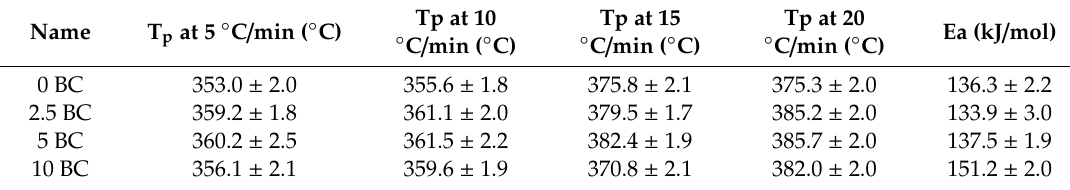
Table 6. Kissinger data of investigated composite in